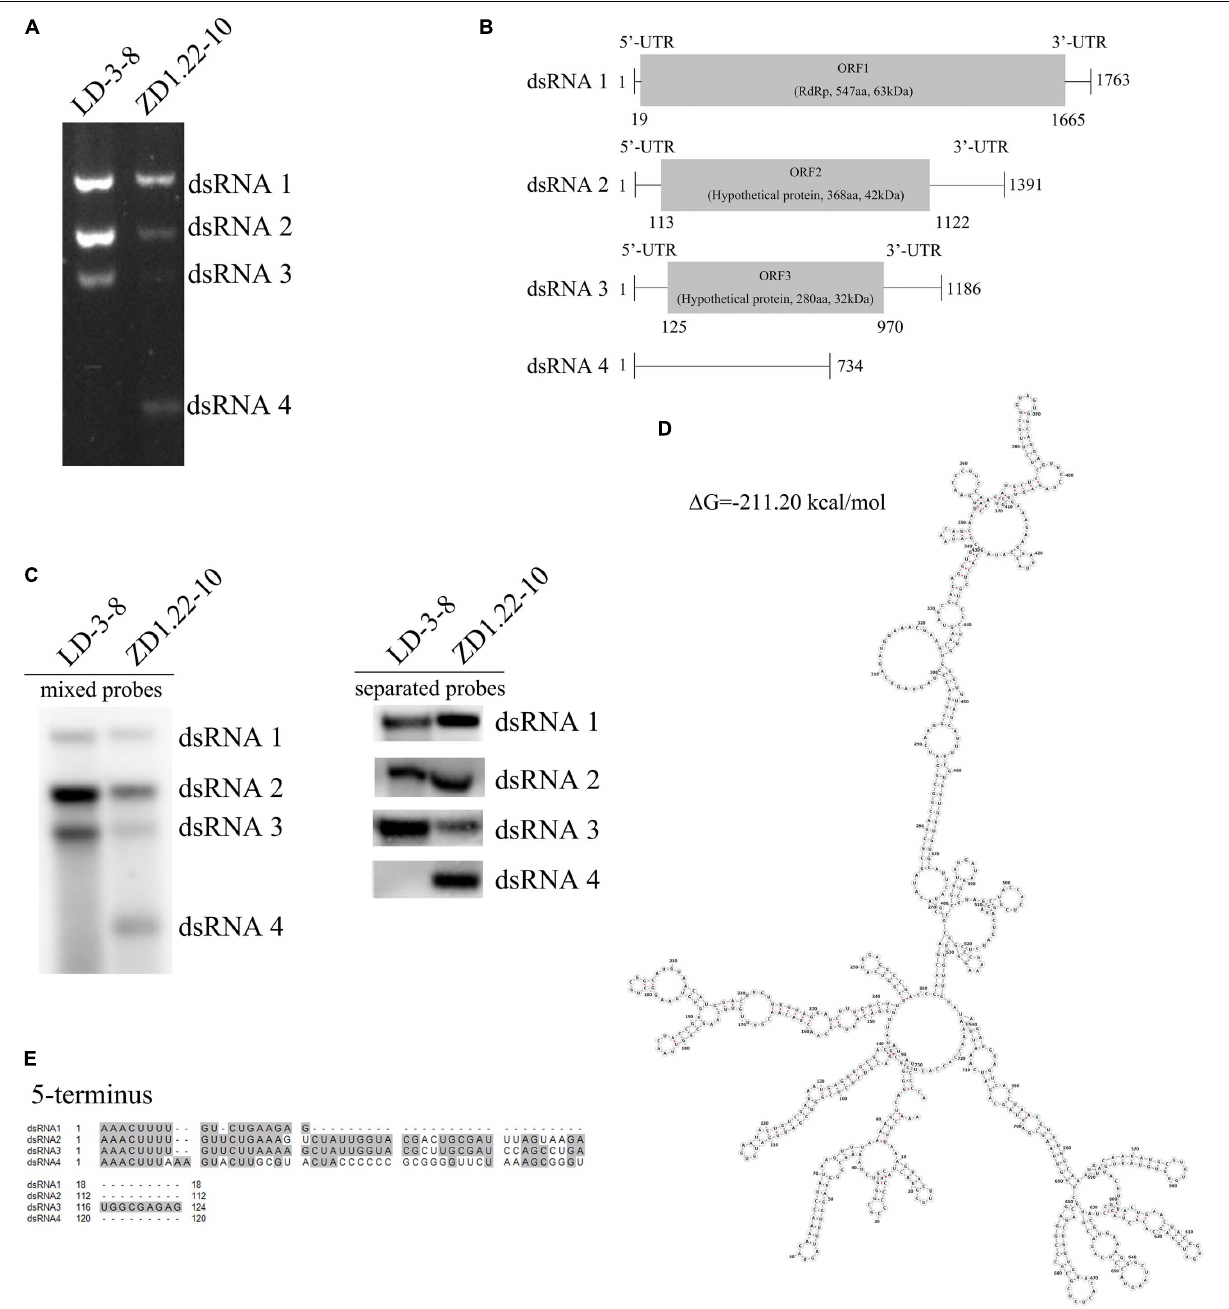
than those of isolate LD-F1-b (AfPV1-infected) ( Figure 3A ), suggesting poor sporulation of isolate LD-F1-b. We also noticed that the size of vacuoles in LD-F1-b (AfPV1-infected) was larger